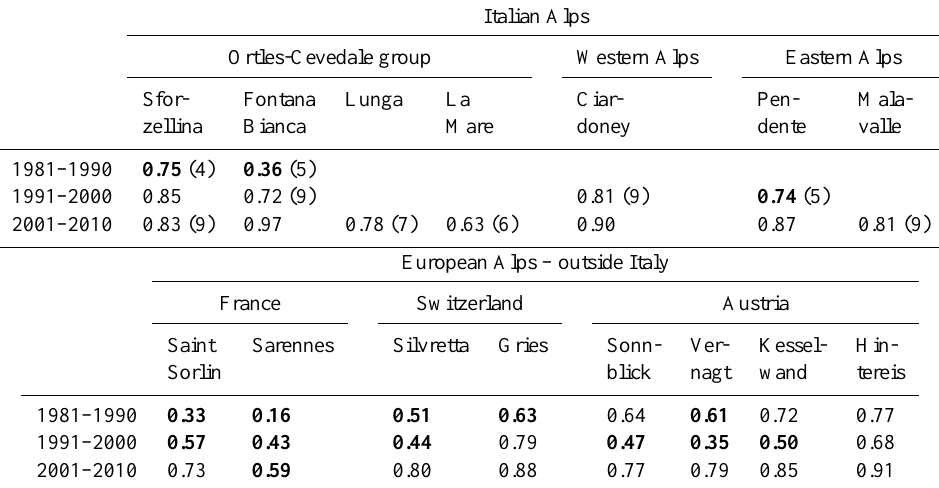
European Alps – outside Italy France